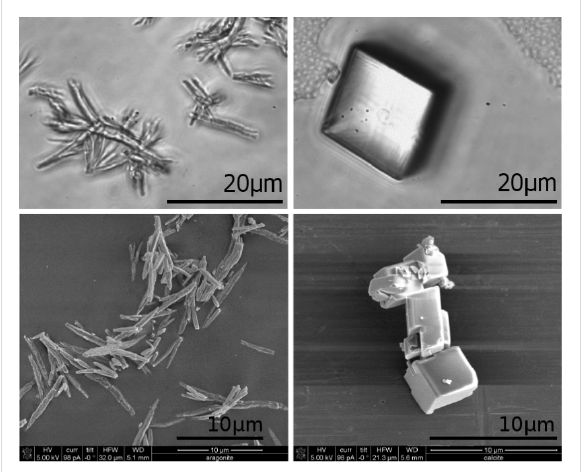
Figure 1: Precipitated aragonite needles (left) and calcite rhombohe- drons (right). Upper: light microscopy images. Lower: scanning elec- tron microscopy images.